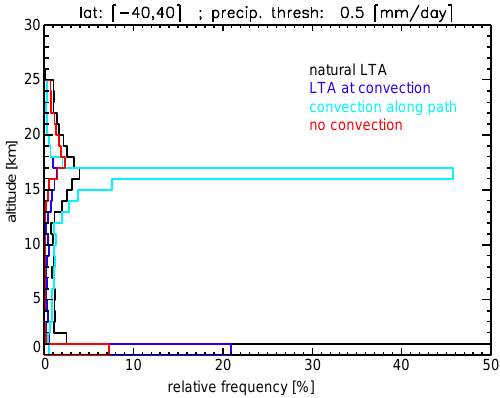
Fig.6. Relativedistributionin[%]ofthemomentumfluxat25 km vs. LTAin[km]forraysterminatingbetween Figure 6. Relative distribution in [%] of the momentum flux at 40 ◦ S–40 ◦ N. Data are averaged over all five one-week periods. The black line shows LTA as determined by 25km vs. LTA in [km] for rays terminating between 40 ◦ S–40 ◦ N. theray-tracer,thedarkbluelineindicatesLTAforonlythosewaveswhichendoverconvection. Thelightblue Data are averaged over all five 1-week periods. The black line shows curveiscalculatedfromrayswhichwereterminatedwhenintersectingprecipitationlargerthan0.5 mmday − 1 . LTA as determined by the ray tracer, the dark blue line indicates Theredlineindicatesthecaseswhichneverpasslocationsofconvection. LTA for only those waves which end over convection. The light blue curve is calculated from rays which were terminated when intersect- ing precipitation larger than 0.5mmday − 1 . The red line indicates the cases which never pass locations of